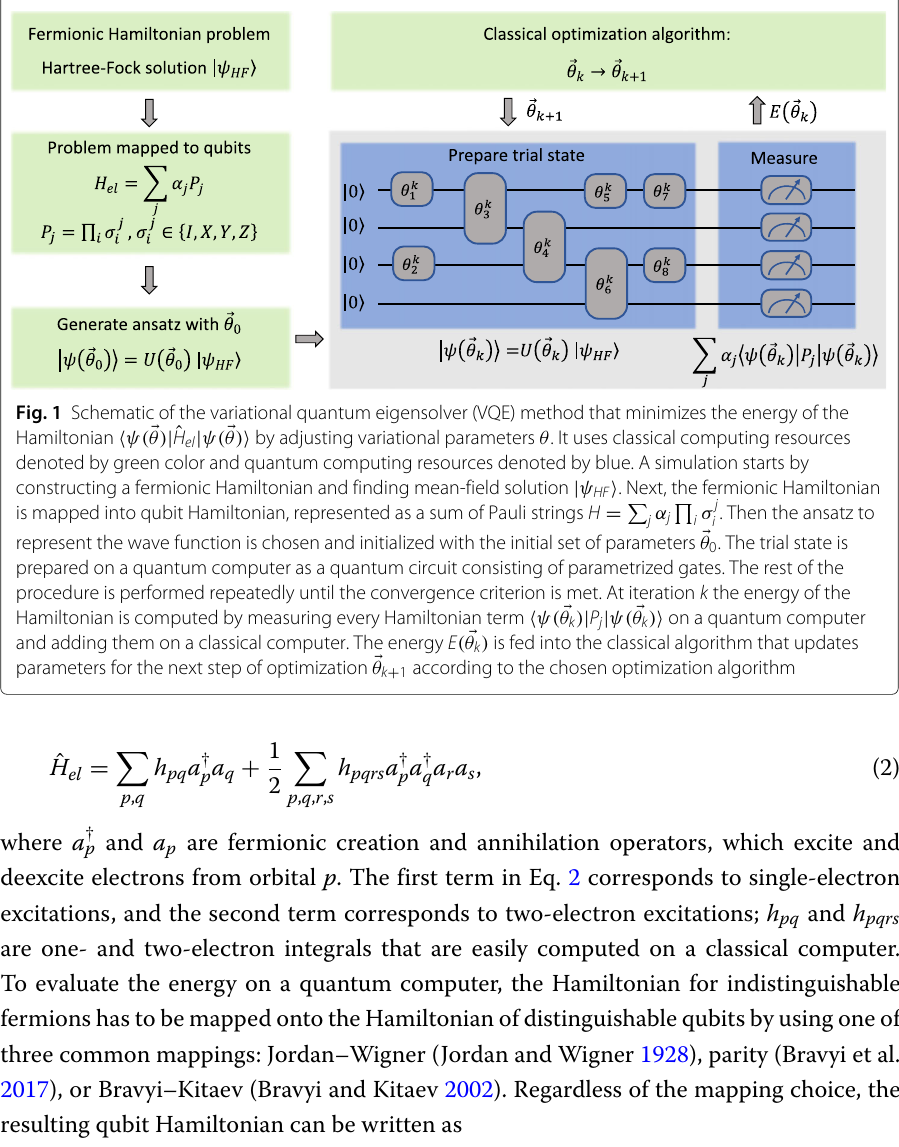
(cid:5) (cid:6) α σ j j j i i . Then the ansatz to